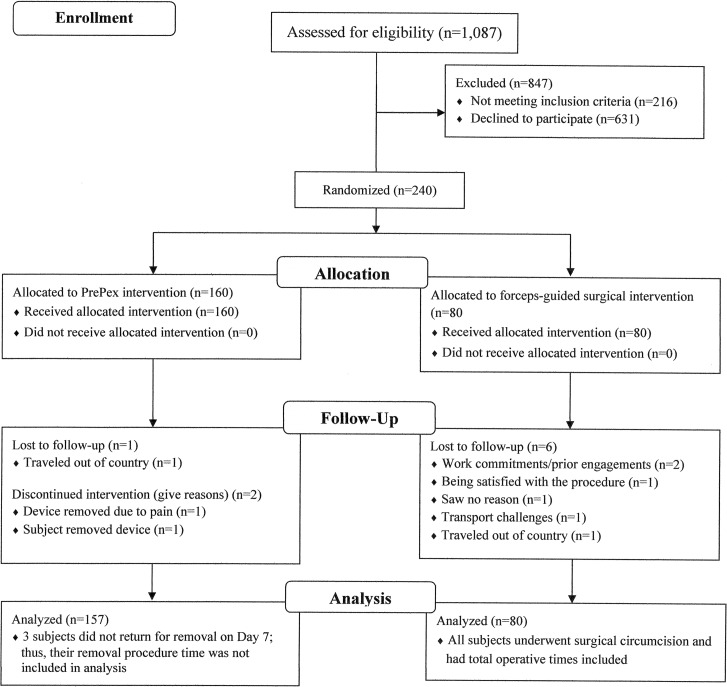
Flow chart summarizing the screening and enrollment of the male participant candidates.